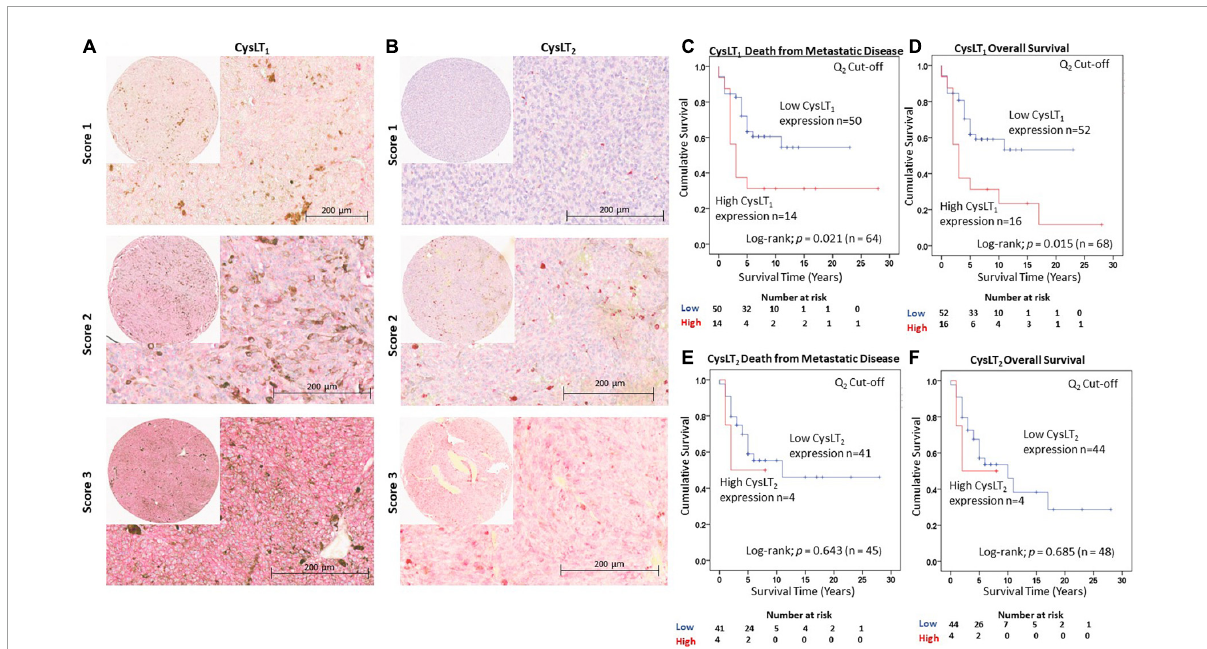
FIGURE1 Validation of the prognostic value of CysLT 1 and CysLT 2 protein expression in an independent cohort of primary UM patients. (A) Representative cores from the Spanish UM patient tissue microarray designated with a score of 1, 2, or 3 for CysLT 1 staining intensity. (B) Representative cores from the same TMA designated with a score of 1, 2, or 3 for CysLT 2 staining intensity. Expression of both CysLT 1 and CysLT 2 was predominantly cytoplasmic in primary UM tumours, with a mixture of membranous and cytoplasmic staining in cores designated a score of 2 and 3. (C) High expression of CysLT 1 (red) is significantly associated with reduced survival from metastatic disease in patients presenting with primary UM ( n = 64; Log Rank; p = 0.021; HR 2.28; 95% CI 1.08–4.78). (D) High expression of CysLT 1 (red) is significantly associated with reduced overall survival in patients presenting with primary UM ( n = 68; Log Rank; p = 0.015; HR 2.27; 95% CI 1.12–4.58). (E) Kaplan-Meier survival curve stratified based on high (red) or low (blue) CysLT 2 expression and death by metastatic melanoma ( n = 45; Log Rank; p = 0.643; HR 1.39; 95% CI 0.32–6.01). (F) Kaplan-Meier survival curve stratified based by high (red) or low (blue) CysLT 2 expression and death by any cause ( n = 48; Log Rank; p = 0.685; HR 1.34; 95% CI 0.31–5.75). The median was used as the cut-off point for high vs. low expression for all Kaplan-Meier survival curves. Number of events indicates the number of deaths due to metastatic melanoma (C,E) . Number of events indicates the number of deaths due to any cause (D,F)